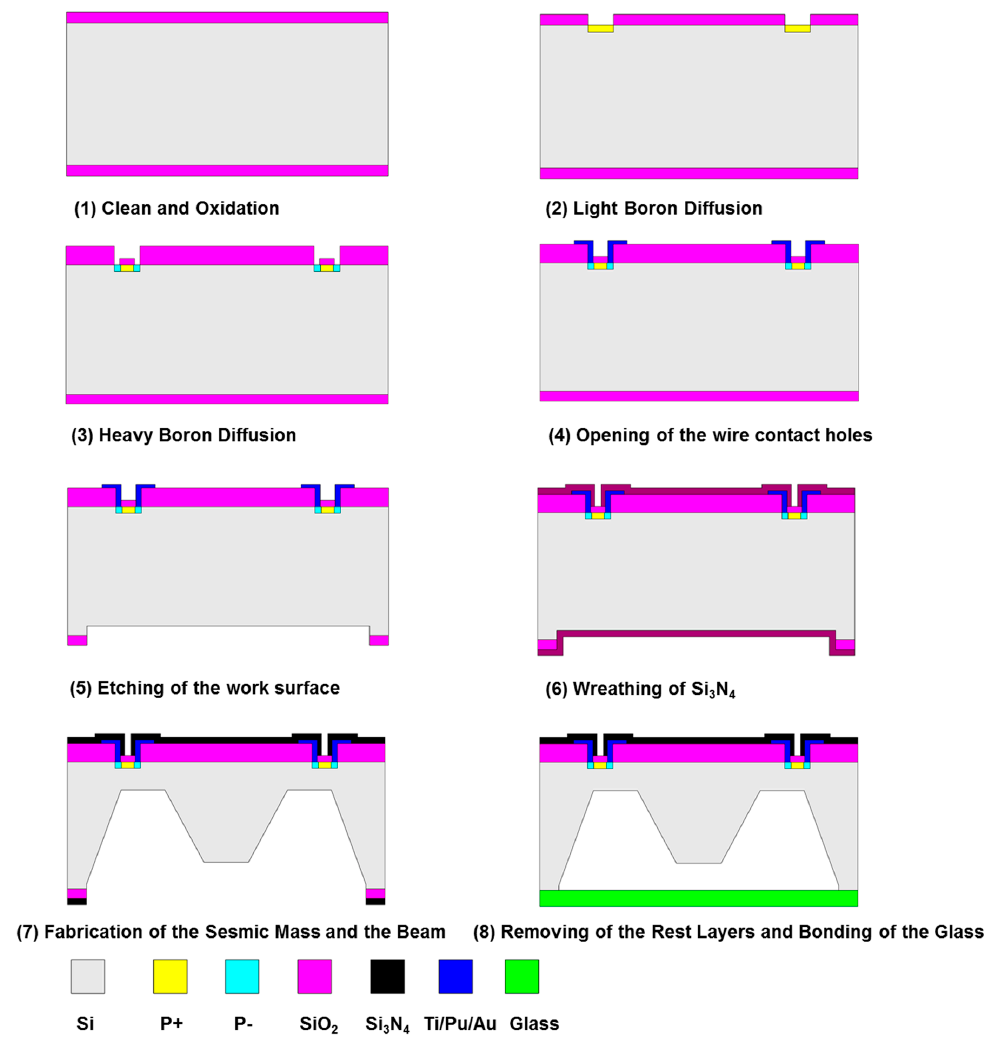
Figure 9. Flow chart of the fabrication process for the sensor chip.